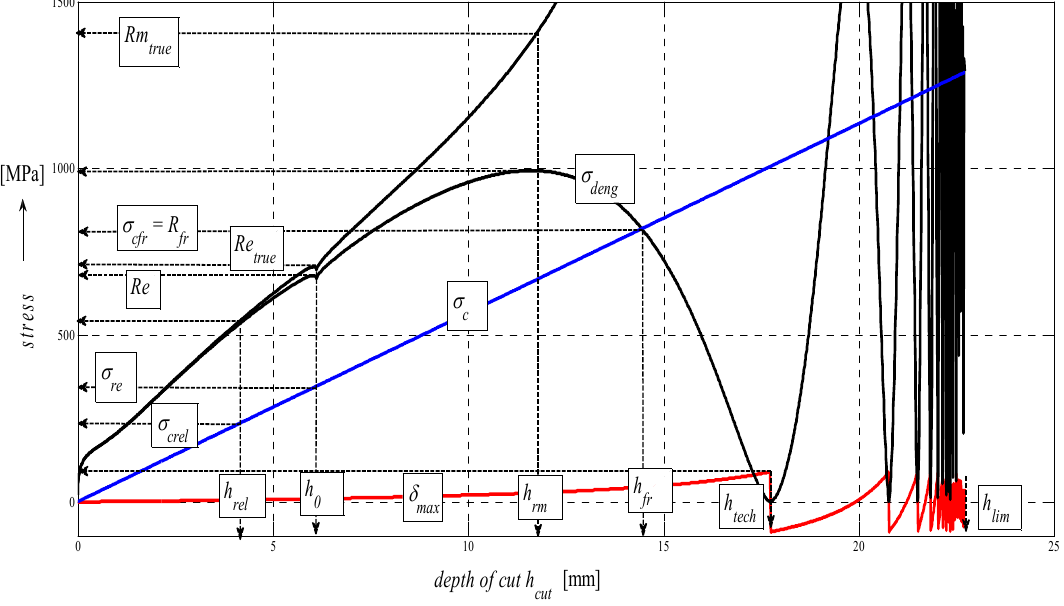
Figure 10. Diagram for STN 15230 steel, dependence of functions on absolute depth.